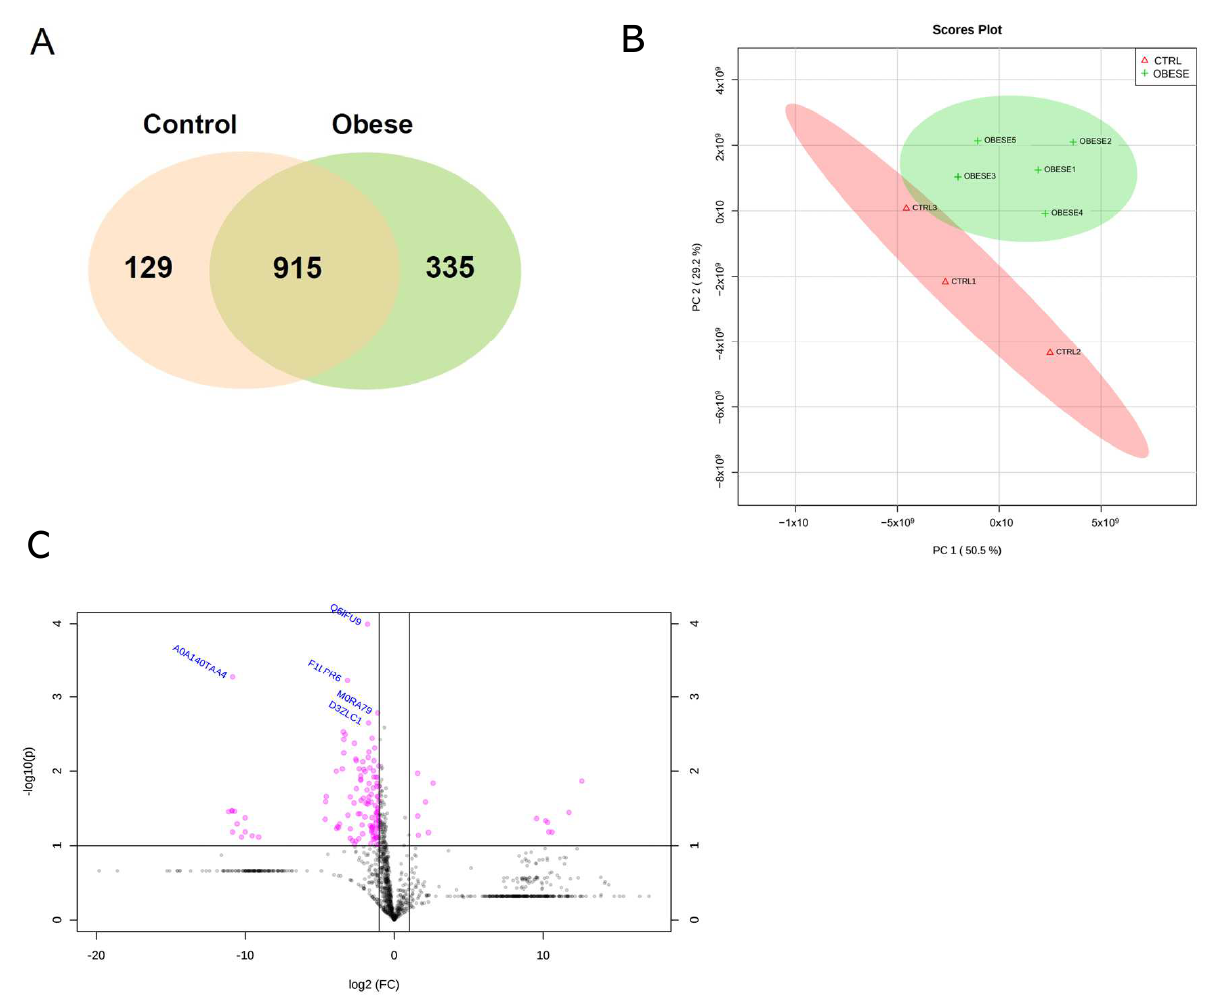
Figure 1. Summary of the proteomic profile of PDL in the control and obese groups. ( A ) Distribution of the total 1379 proteins identified in both groups (915) and exclusively in the control (129) and obese (335) groups, as shown by Venn diagram. ( B ) Difference between the samples of the control (CTRL) and obese groups and the similarity between the samples within each group, as exhibited by PCA. ( C ) Distribution of significantly differentially regulated proteins ( p < 0.05) in the PDL of the control (left side) and obese (right side) groups determined by the beta-binomial statistical test ( p < 0.05), as illustrated by a volcano plot.